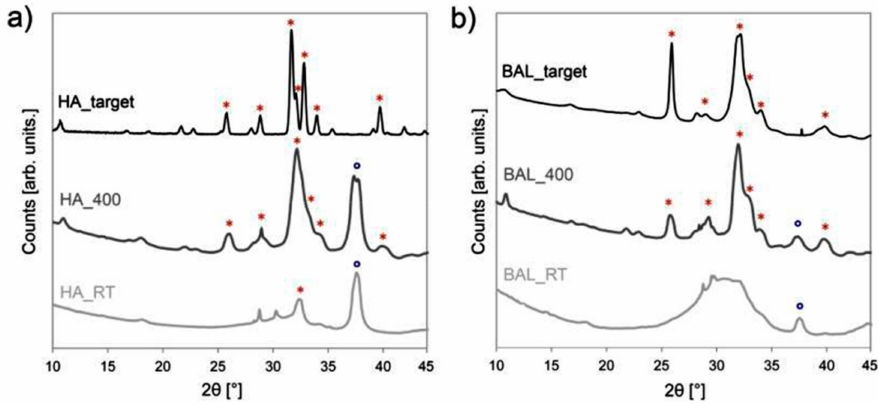
Figure 6. XRD spectra of the hydroxyapatite (HA) ( a ) and bone apatite-like (BAL) ( b ) targets; as-deposited and annealed films. Reprinted with permission from [73]. © 2017 Elsevier.